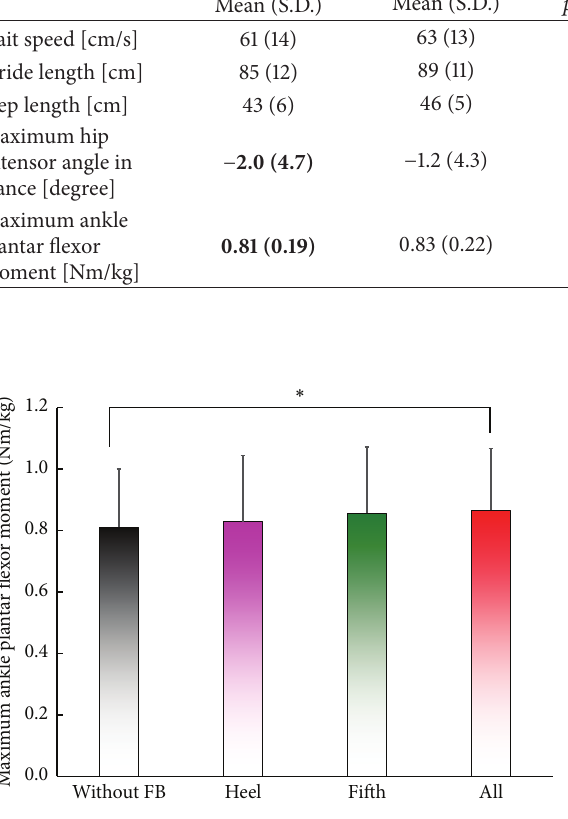
Figure 5: Effects on the maximum ankle plantar flexor moment of the affected side. ∗ 𝑝 < 0.05 , two-tailed. A significant difference is found between (i) “without” and (iv) “all”